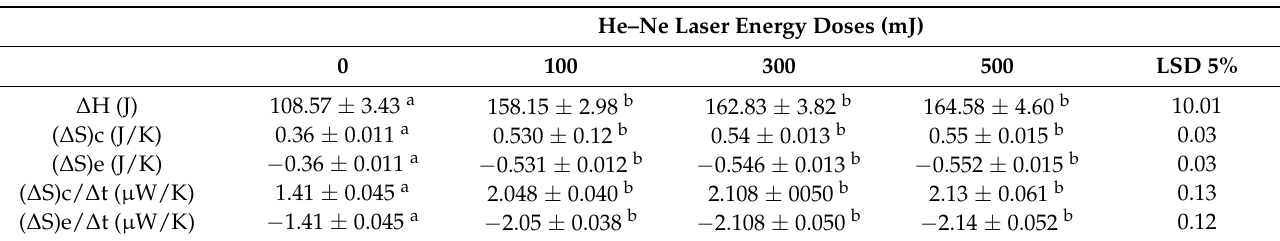
Table 1. Different seed thermodynamic attributes of germinating safflower seeds irradiated with He–Ne laser of different energies (mean ± S.E